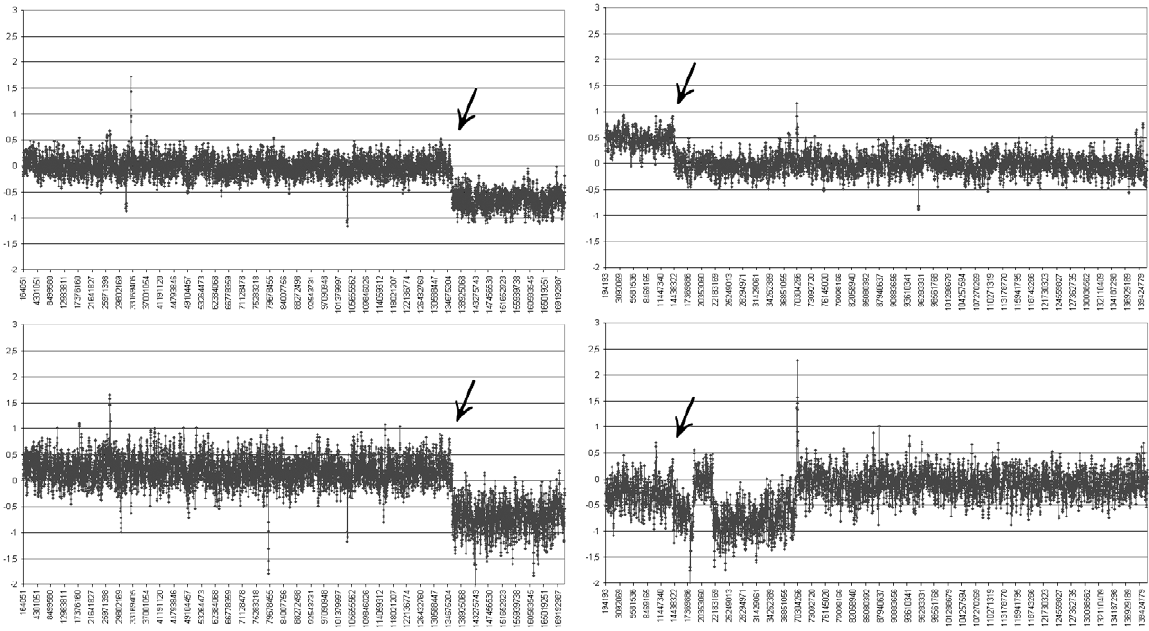
Fig. 4. The left panel shows the microarray CGH profile of chromosome 6 of cases E and F, both carrying a telomeric deletion that begins at the same 6q23.3 breakpoint, marked by an arrow. The right panel shows the microarray CGH profile of chromosome 9 of cases E, carrying a gain and of case F carrying three distinct regions with copy number loss. The arrows mark the common 9p22.3